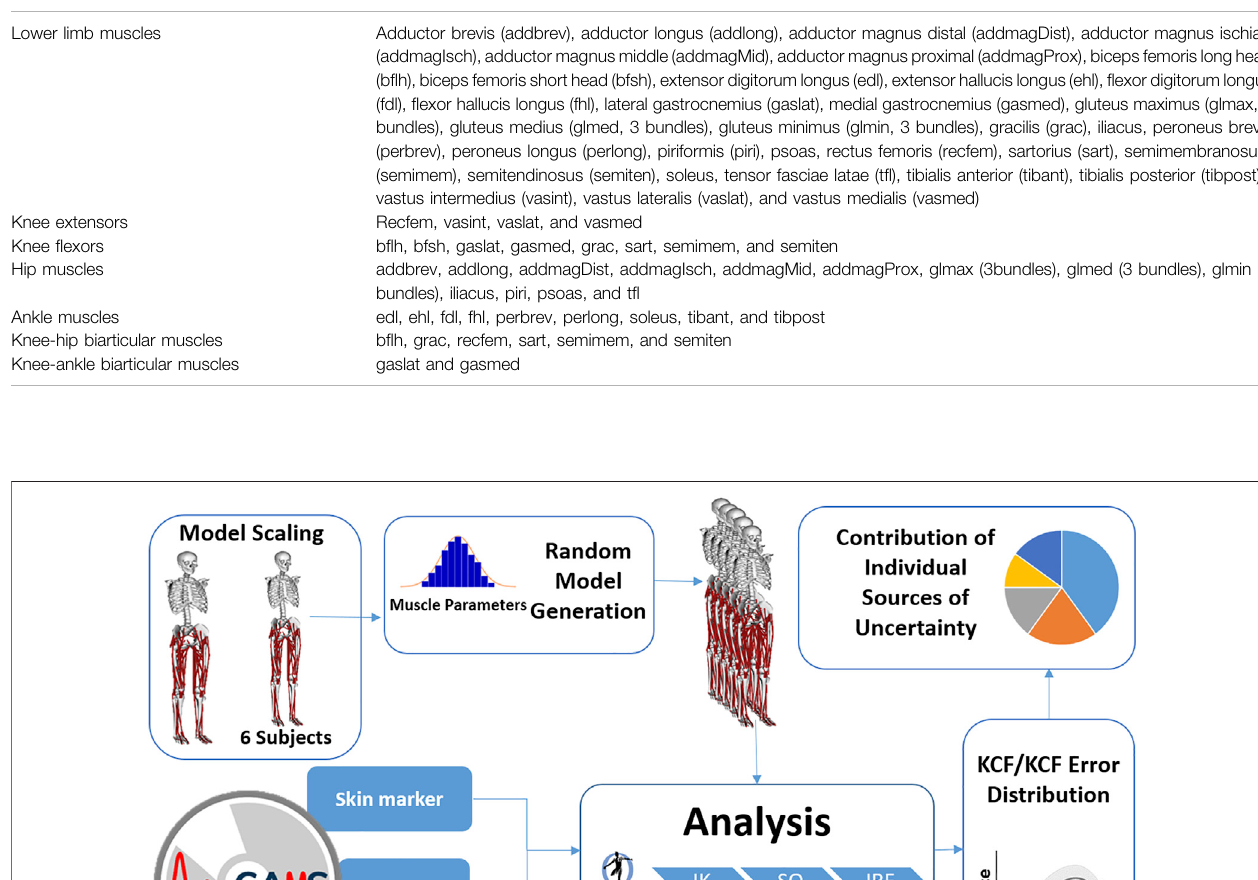
Frontiers in Bioengineering and Biotechnology |